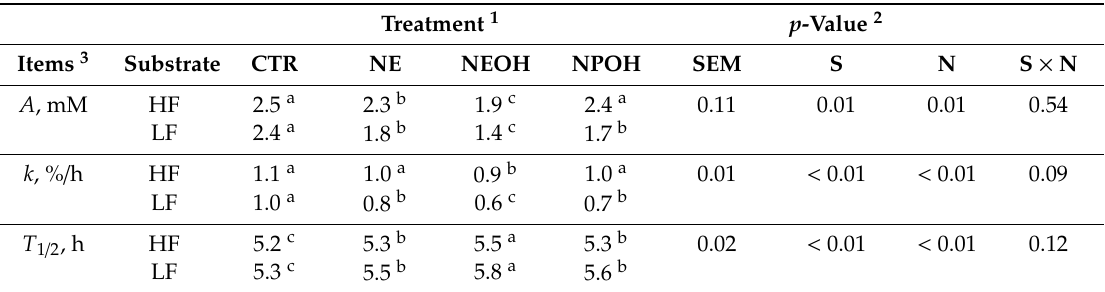
Table 5. The accumulation kinetics of ammonia N during in vitro ruminal fermentation of substrates withahigh(HF)andlow(LF)foragecontentincubatedinbatchculturesofmixedrumenmicroorganisms. Treatment 1 p -Value